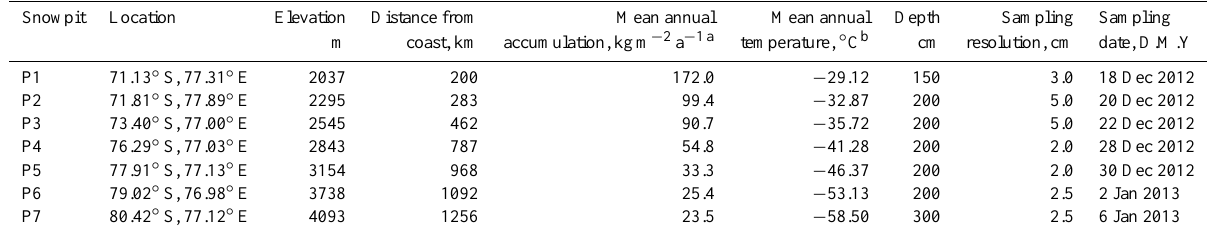
Table 1. Summary information for the seven snowpits presented in this study. Snowpit Location Elevation Distance from Mean annual Mean annual Depth Sampling Sampling m coast, km accumulation, kgm − 2 a − 1a temperature, ◦ C b cm resolution, cm date, D.M.Y P1